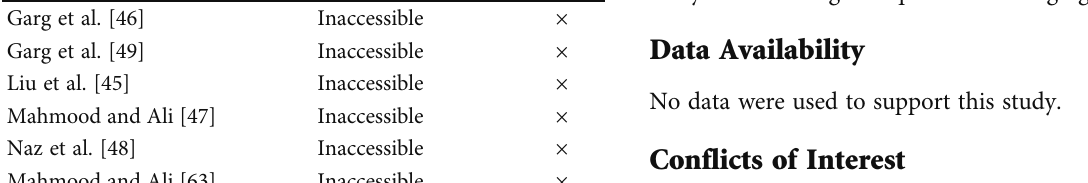
Table 10: Di ff erent methods and their ranking.